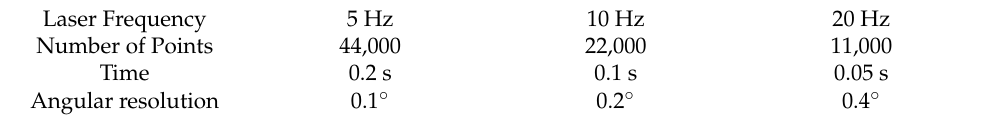
Table 1. Number of points in one frame. Laser Frequency 5 Hz 10 Hz 20 Hz Number of Points 44,000 22,000 11,000 Time 0.2 s 0.1 s Angular resolution 0.1 ◦ 0.4